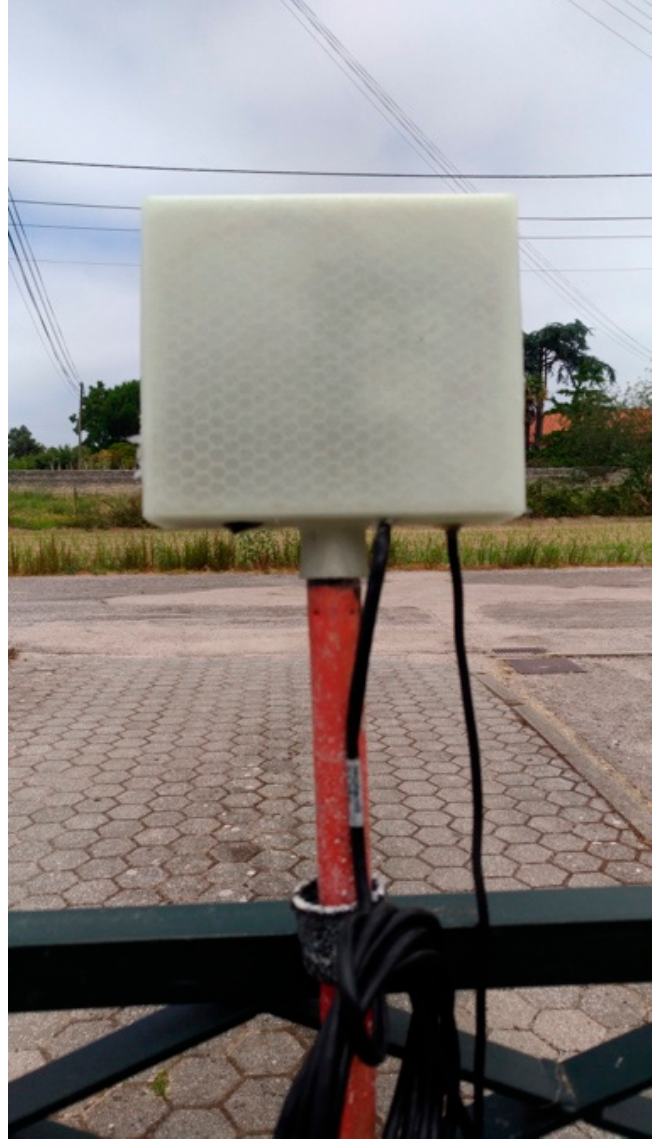
Figure 5. System gateway.